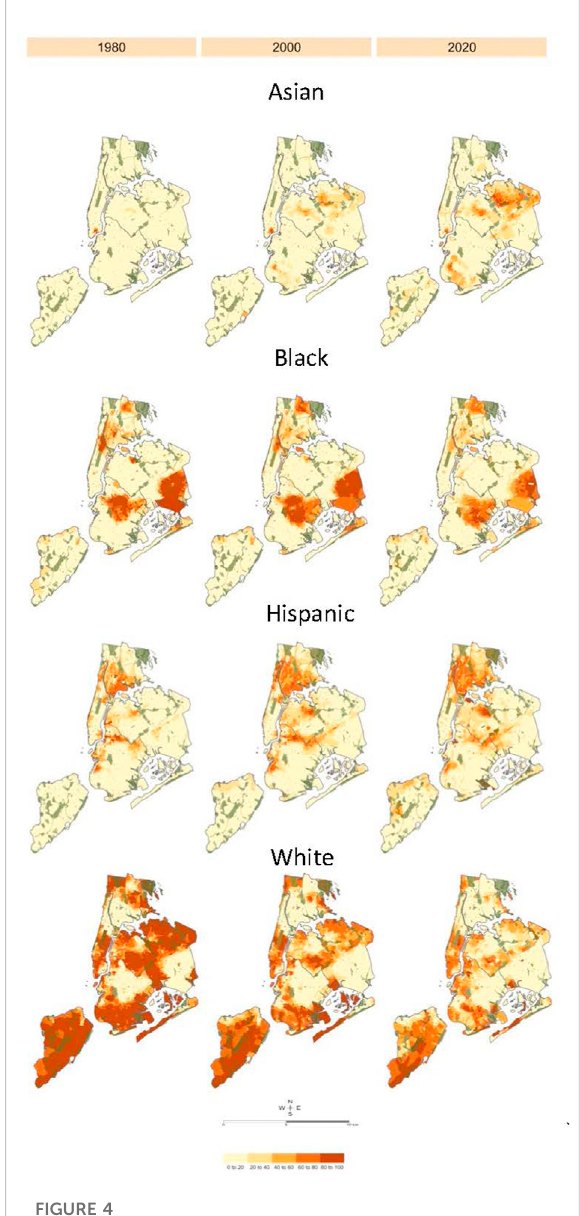
FIGURE 4 Percent of the population by race and ethnicity, New